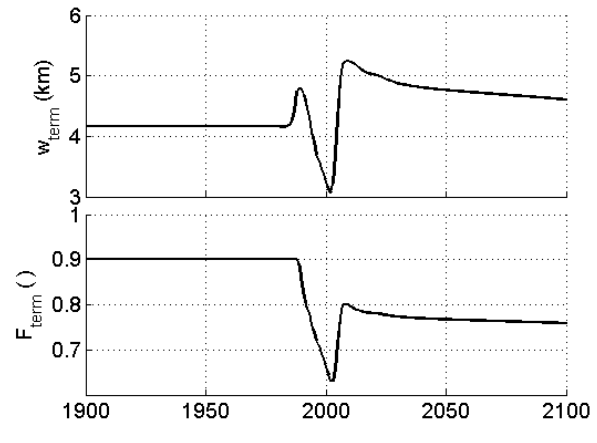
Fig. 14. Ensemble mean time-series of terminus glacier width ( w term ) and correction factor ( F term )